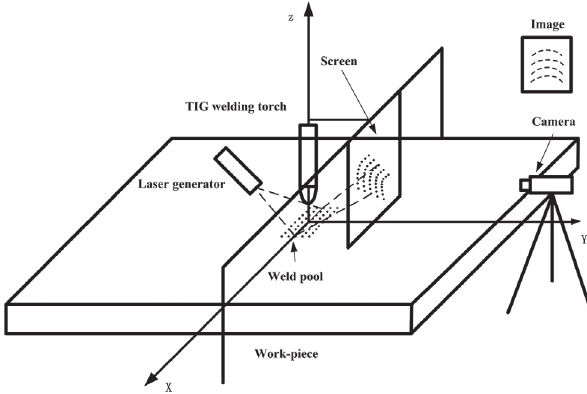
Figure 1: The experimental principle of measurement using dots laser vision.